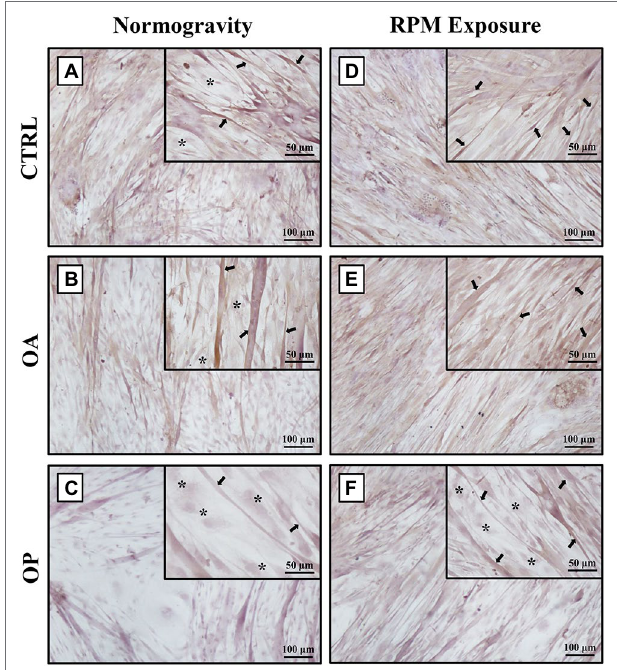
FIGURE 1 | Morphological analysis by light microscopy of primary cultures of human satellite cells subjected to normogravity regimen and RPM exposure. In normogravity conditions, primary cultures from CTRL (A) and OA (B) patients were characterized by a heterogeneous population of numerous myotubes (arrows) and rare single satellite cells (asterisks), whereas primary cultures from OP patients (C) consisted of rare myotubes (arrows) and numerous single satellite cells (asterisks). RPM exposure caused an increase in the number of myotubes (arrows) in primary cultures from CTRL (D) and OA (E) patients. Samples derived from OP patients (F) showed not only single satellite cells (asterisks), but also several myotubes (arrows). Satellite cells (asterisks) were characterized by immunofluorescence for Pax7 (see Supplementary Figure S1 ). 4× images, scale bar represents 100 μ m; 20× images, scale bar represents 50 μ